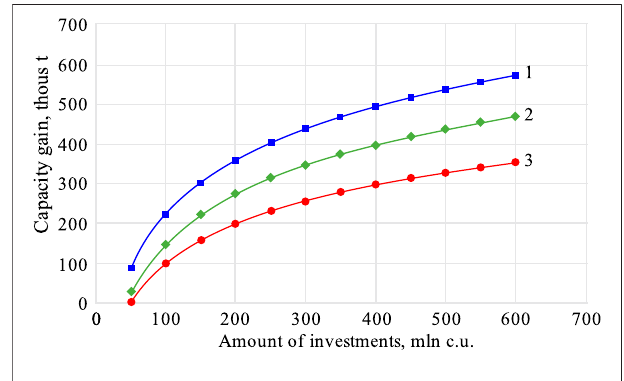
FIGURE 1 | Dependence of changes in mine capacities depending on the investment volumes in terms of three mines of State Coal Company